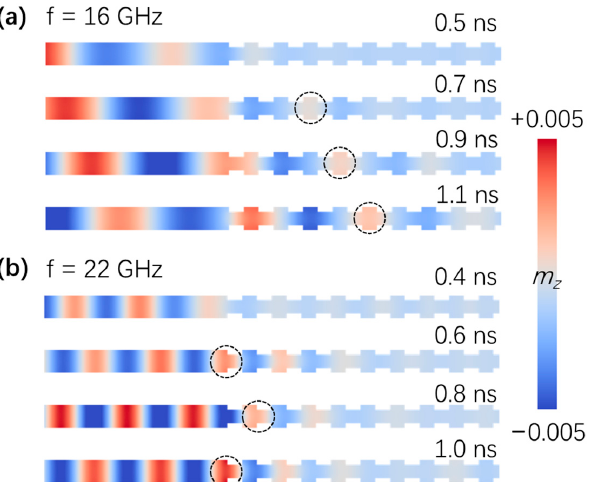
Figure 5. ( a ) Spin-wave propagation along the width-modulated nanostrip with an electric field of 0.1 V/nm. The frequency of the excitation field was f = 16 GHz, which was not in the band gaps. As expected, the spin waves moved forwards along the waveguide. ( b ) The spin waves failed to pass through the width-modulated region when the excitation frequency was f = 22 GHz with the applied electric field.